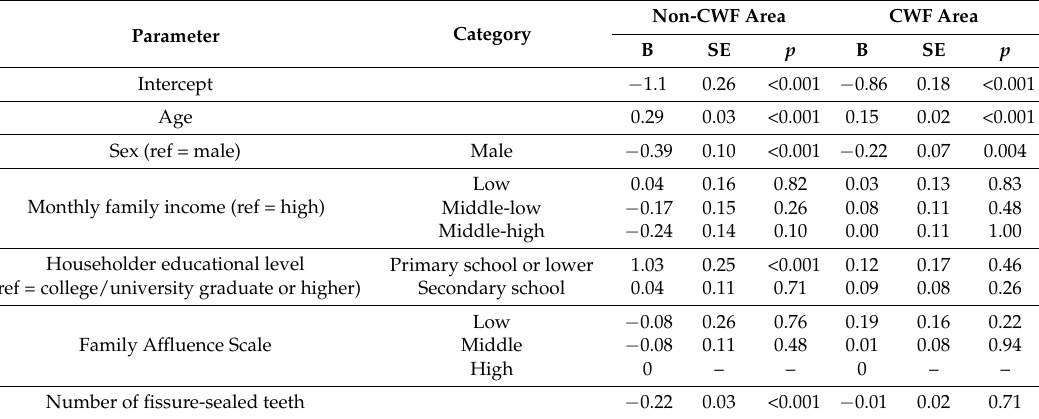
Table 5. Univariate analysis of variance for decayed, missing, and filled teeth